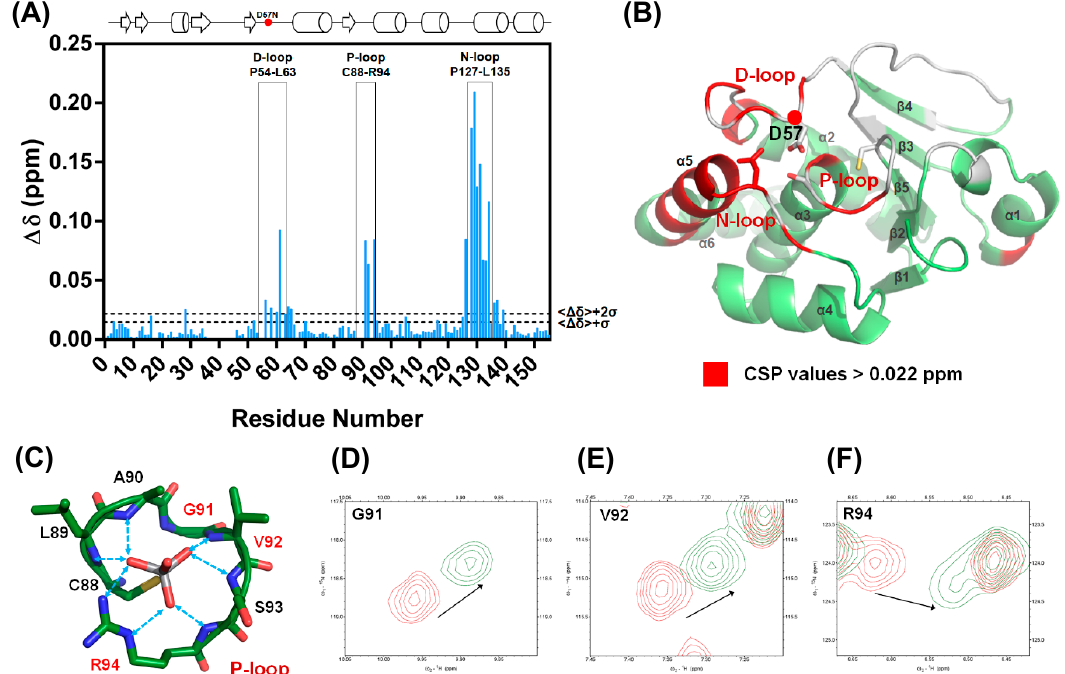
Figure 3. The D57N mutant exhibited a perturbed conformation as a result of DPN–triloop interactions. ( A ) The catalytic residue, D57, was replaced with asparagine, and the chemical shift perturbation (CSP) values were calculated. The threshold was set at ∆ δ + 2 σ , and the value was 0.022 ppm. The data indicated that the residues in the D-loop, P-loop, and N-loop were specifically perturbed by the D57N mutant. ( B ) The residues with CSP values greater than ∆ δ + 2 σ are labeled on the DUSP22 structure in red. These results revealed the region that was perturbed by DPN–triloop interaction, including the D-loop, P-loop, N-loop, and α -helix 5 ( α 5). The spaces and white residues were non-assigned residues in the backbone assignment, including proline and disappeared signals in the 3D spectra. ( C – F ) The P-loop is the binding site, and the residues in the P-loop share their backbone amides as well as side chains to interact with the ligands. The 1 H-, 15 N-HSQC spectrum of the WT (red) was superimposed with the spectrum of D57N (green) to show that the P-loop residues, G91, V92, and R94, were perturbed by disruption of the DPN–triloop